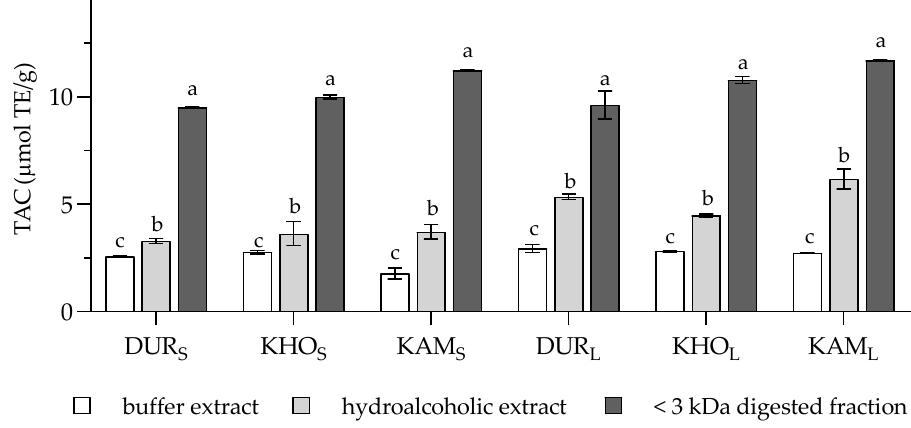
Figure 3. Total antioxidant capacity (TAC) of buffer and hydroalcoholic extracts and <3 kDa digested fractions of the experimental cookies. Values are expressed as mean ± SD ( n = 3). Statistical analysis was by two-way ANOVA followed by Tukey’s HSD test. Within each cookie type, different letters indicate statistical significance among samples ( p < 0.05).